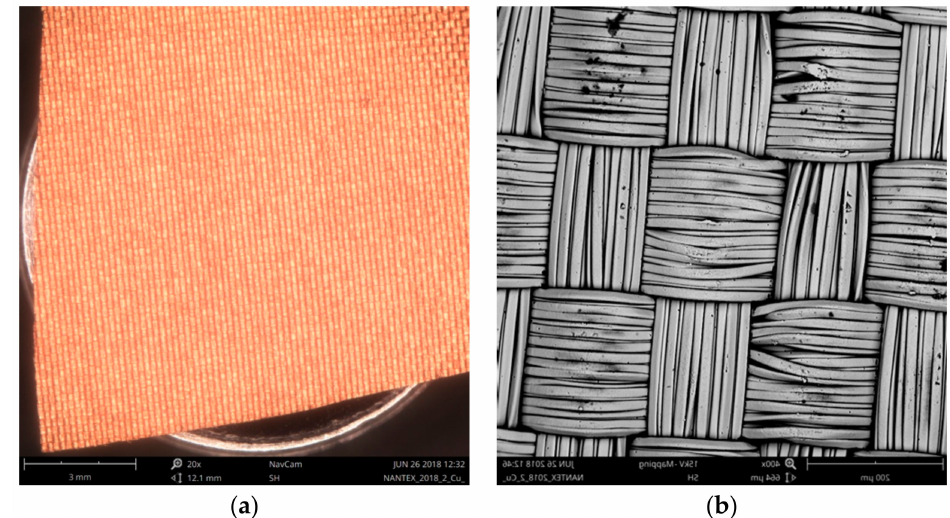
Figure 8. A sample of RSKCuIv4 ( a ), and detail of the sample structure ( b ).